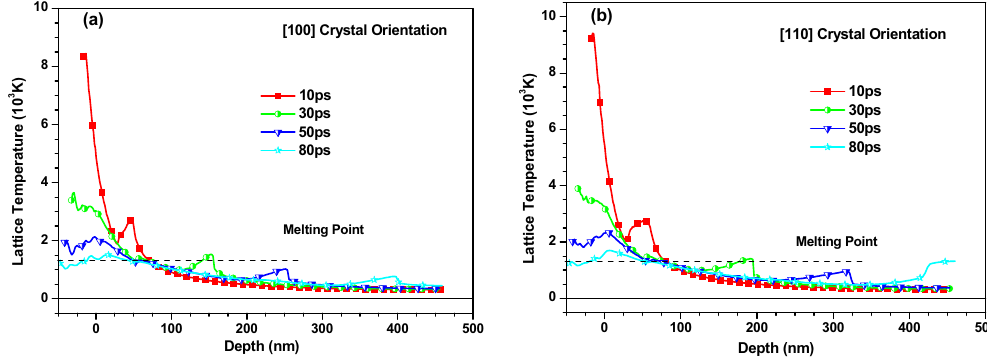
Figure 2. Temperature distribution of ( a ) 〈 100 〉 and ( b ) 〈 110 〉 copper films under an absorbed laser intensity of 0.065 J/cm 2 at 10 ps, 30 ps, 50 ps and 80 ps time instant.